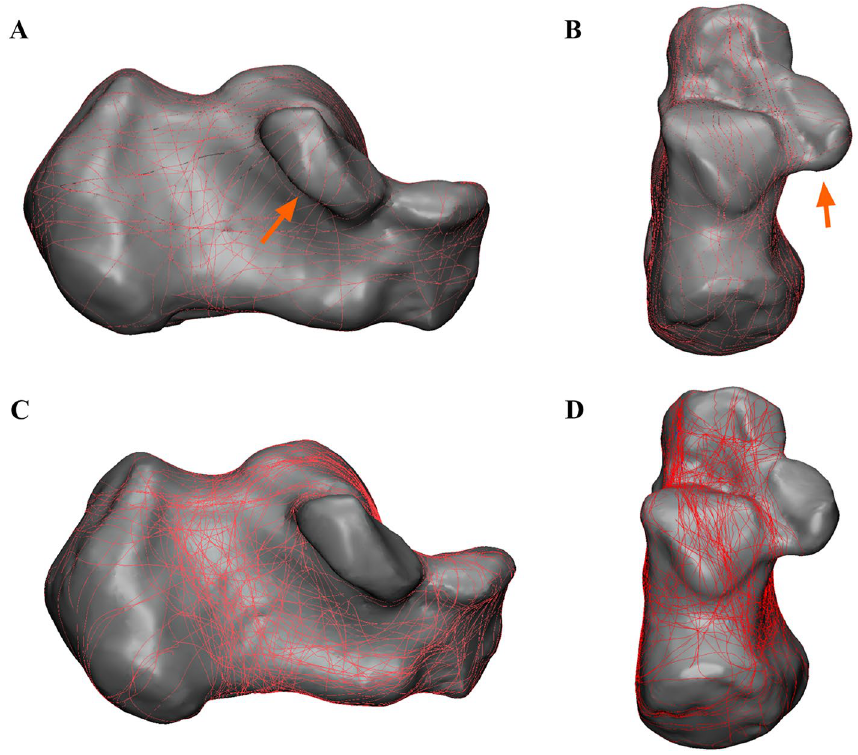
Figure 3. The method used for 3D CT mapping of sustentacular fracture. ( A , B ) Representative views of the 3D map of the 21 sustentacular fracture lines. ( C , D ) Representative views of the 60 patients without sustentacular